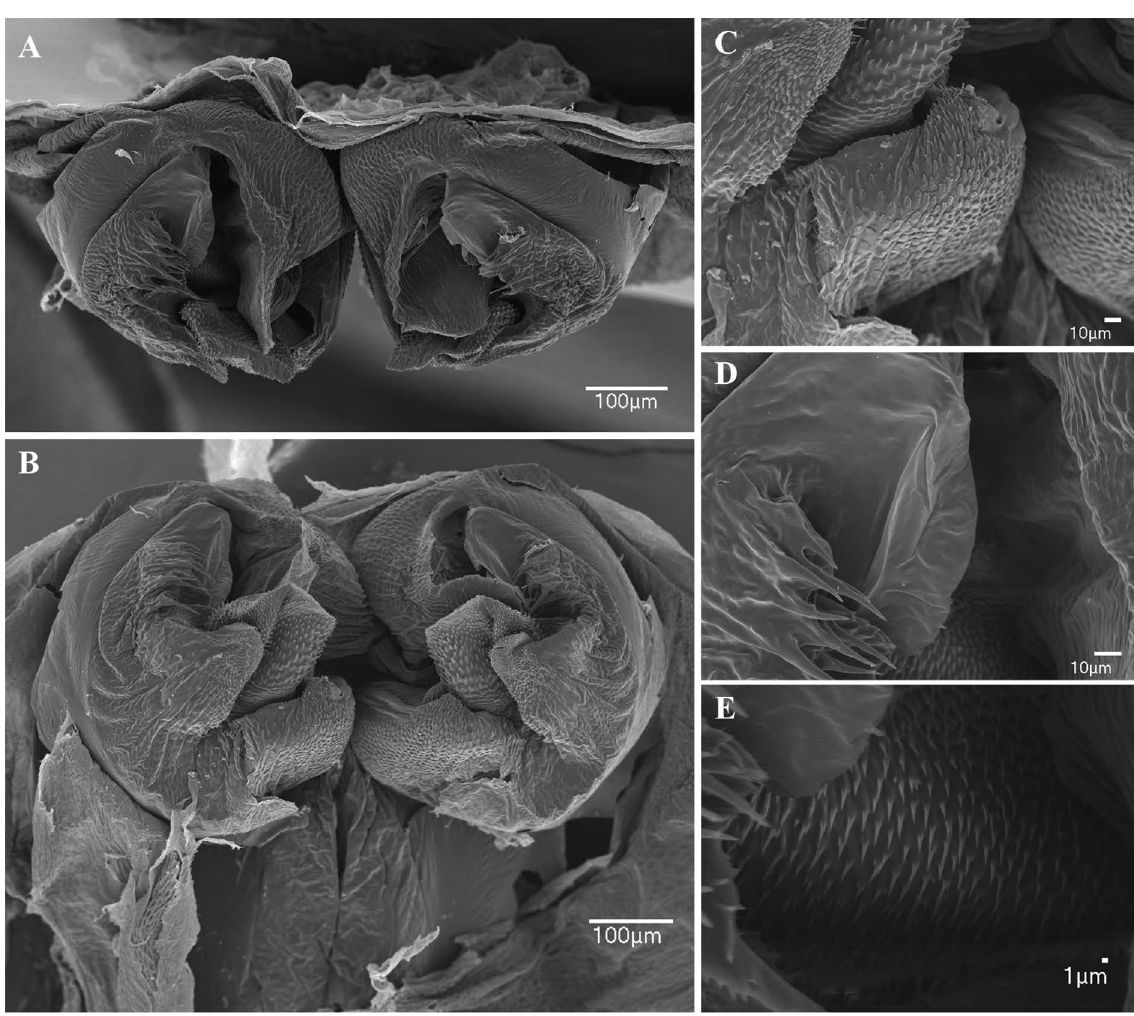
Fig. 97. Charinus elegans Weygoldt, 2006 (MHNG), male gonopod. A . Ventral view. B . Posterior view. C . Dorsal lobe. D . Lateral lobe 2 and processus internus. E . Inner region of fistula (behind PI) showing spiny surface. F . Pedipalp, ventral view. Scale bars: A, E–F = 1 mm; B–D = 0.5